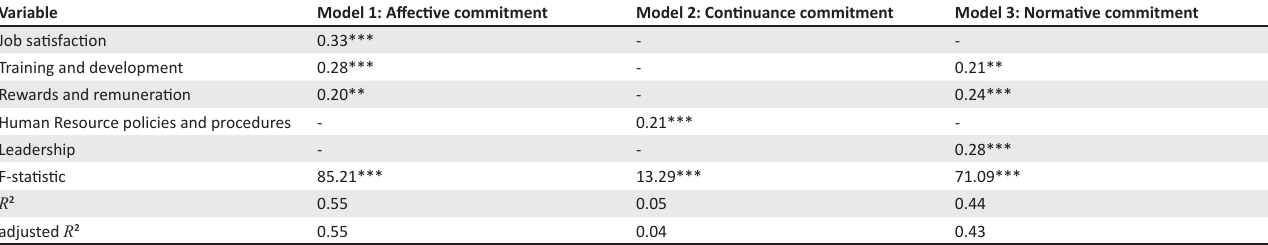
TABLE 2: Stepwise regression results – significant human resource practices as predictors of affective, continuance and normative